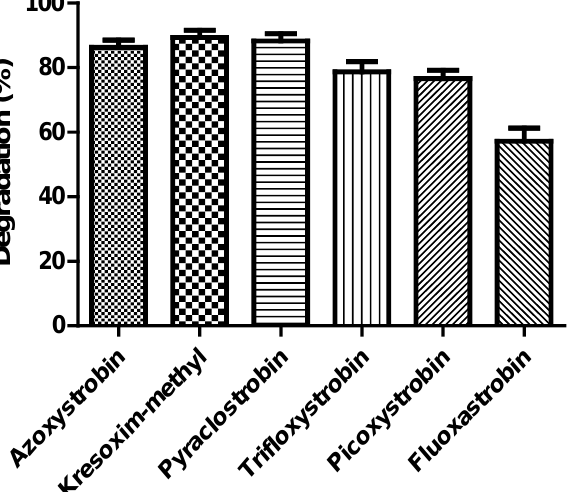
Figure 7. Degradation of various strobilurins by strain SH14 within 5 days. Data represent mean values of three replicates with standard deviation. Table 4. Kinetic parameters of various strobilurin fungicides degradation by strain SH14.